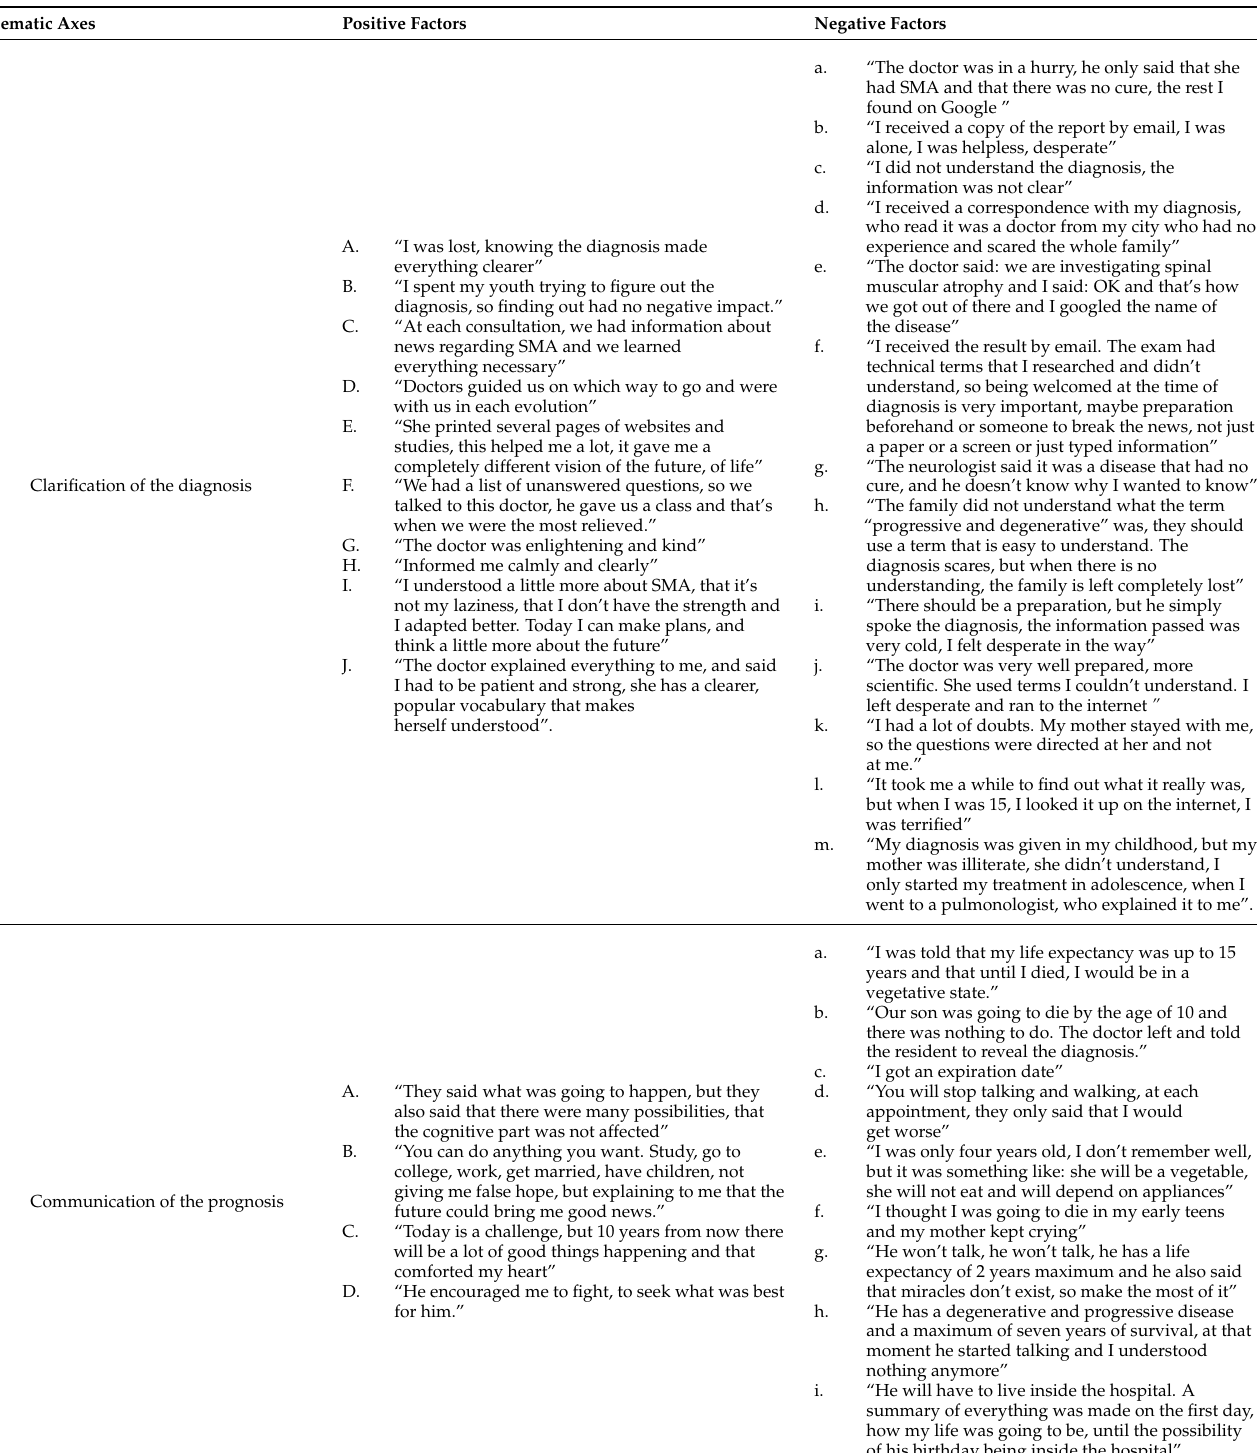
Table 2. Reports of positive and negative experiences related to the moment of communicating the diagnosis of spinal muscular atrophy from the perspectives of patients and family members during the semi-structured